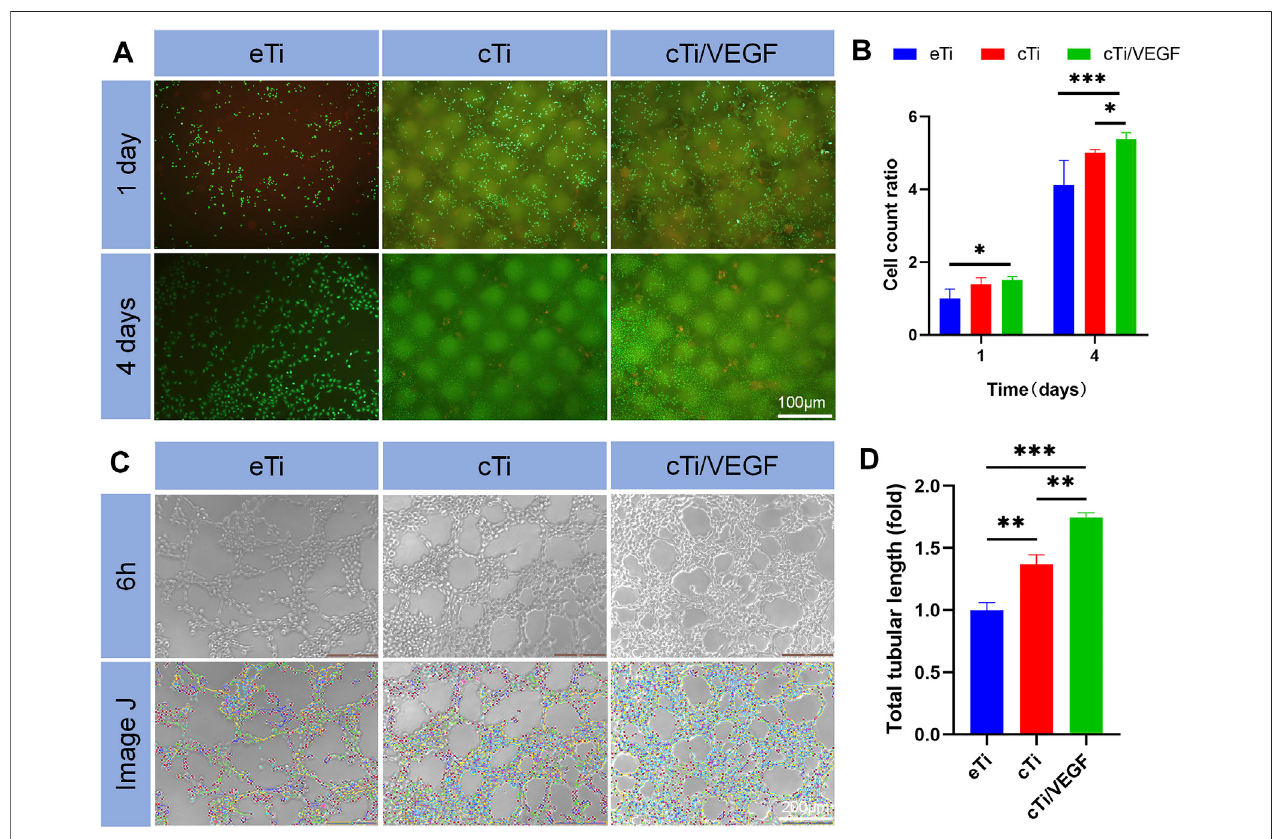
FIGURE 2 | (A) Live/dead HUVECs staining was done in a co-culture of HUVECs with eTi, cTi, and cTi/VEGF for 1 and 4 days, respectively (n (cid:1) 3) (B) Total cellular countwasevaluatedviagrossobservation,underaninvertedmicroscope (C) TubeformationofHUVECsculturedwithExtractsofeTi,cTi,orcTi/VEGFfor6 h(n (cid:1) 3) (D) The total tubular lengths of HUVECs in different